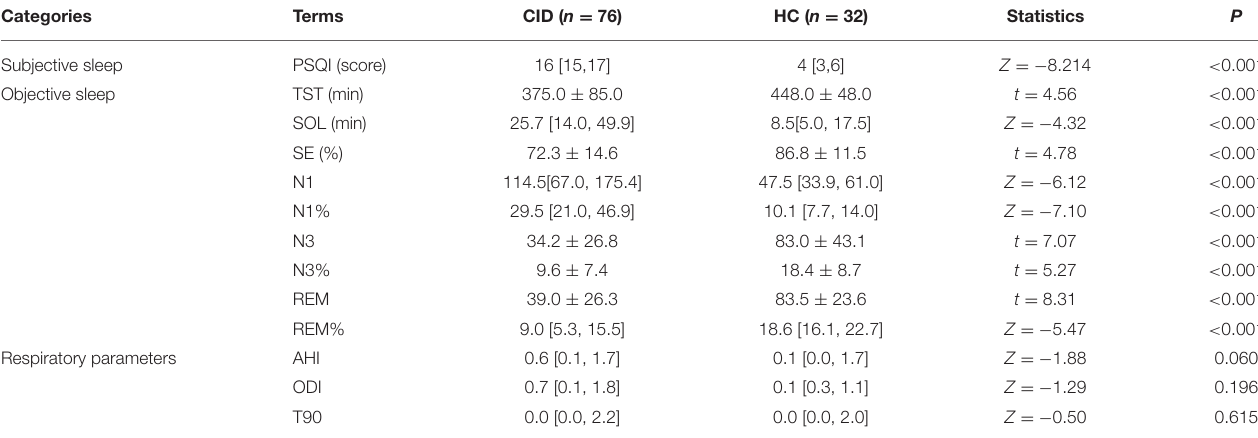
TABLE 2 | Sleep quality and respiratory parameters.